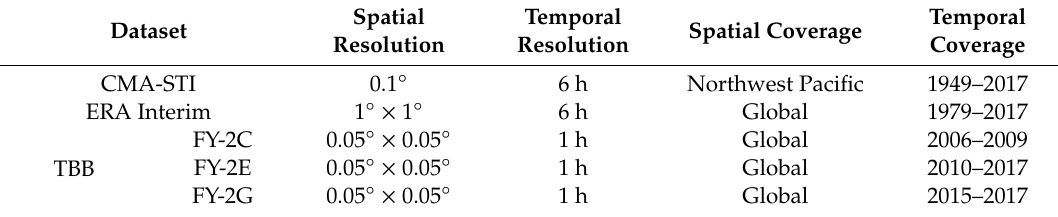
Table 1. Dataset characteristics.